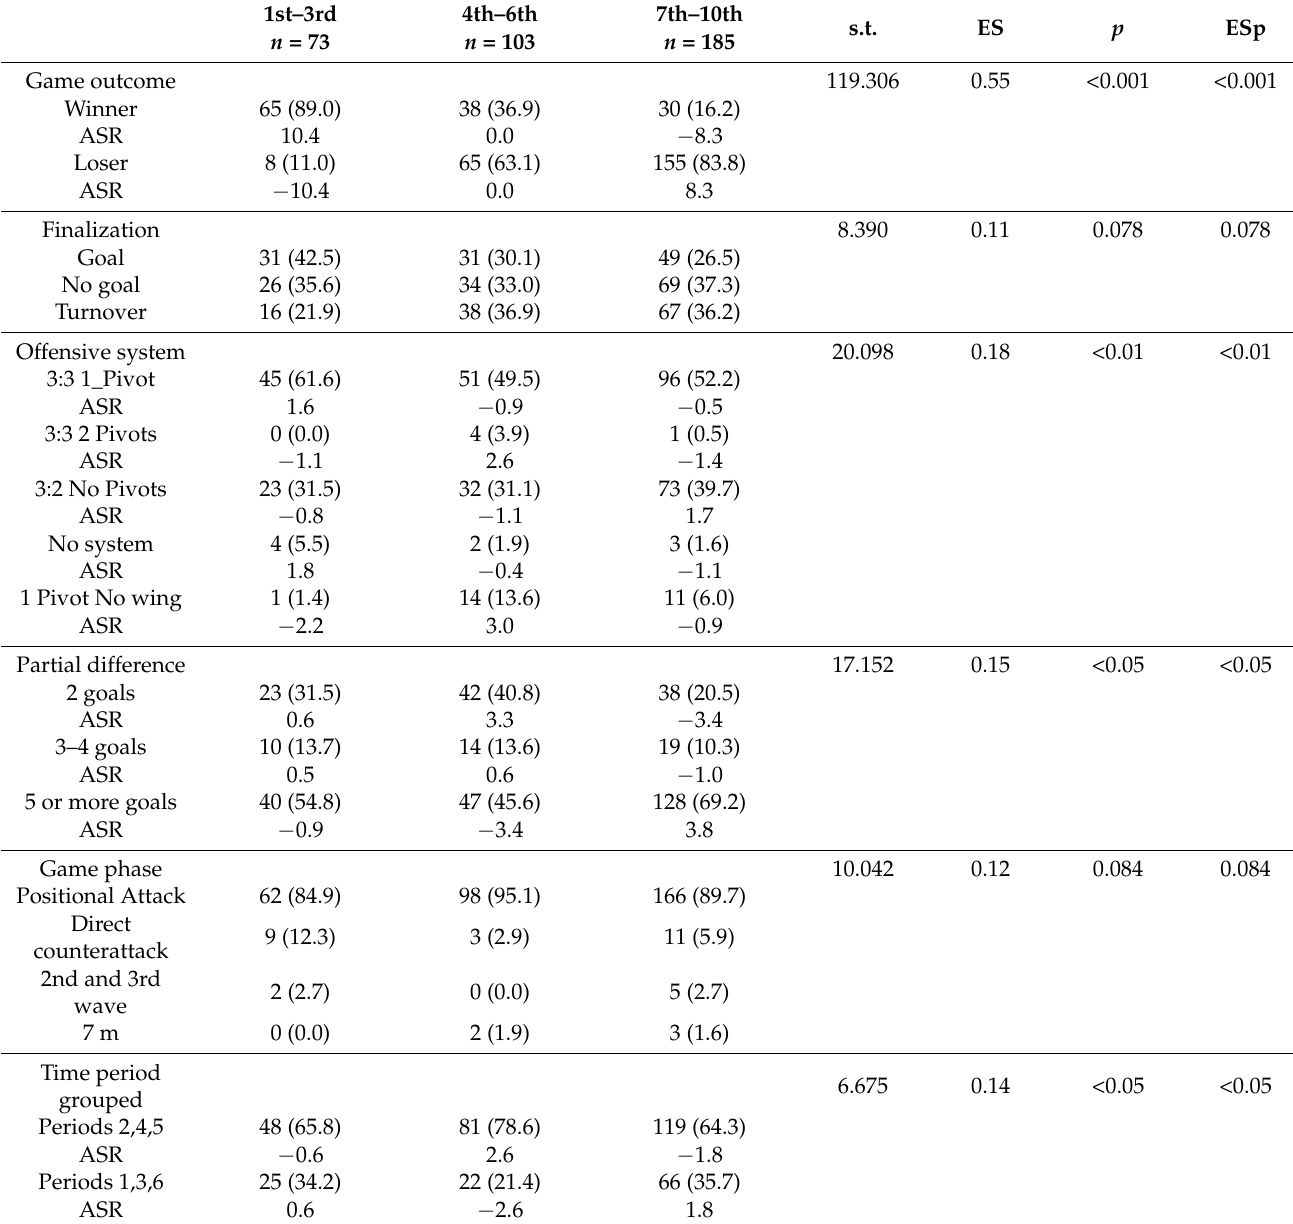
Table 4. Frequency distribution of offensive situations under inferiority during the